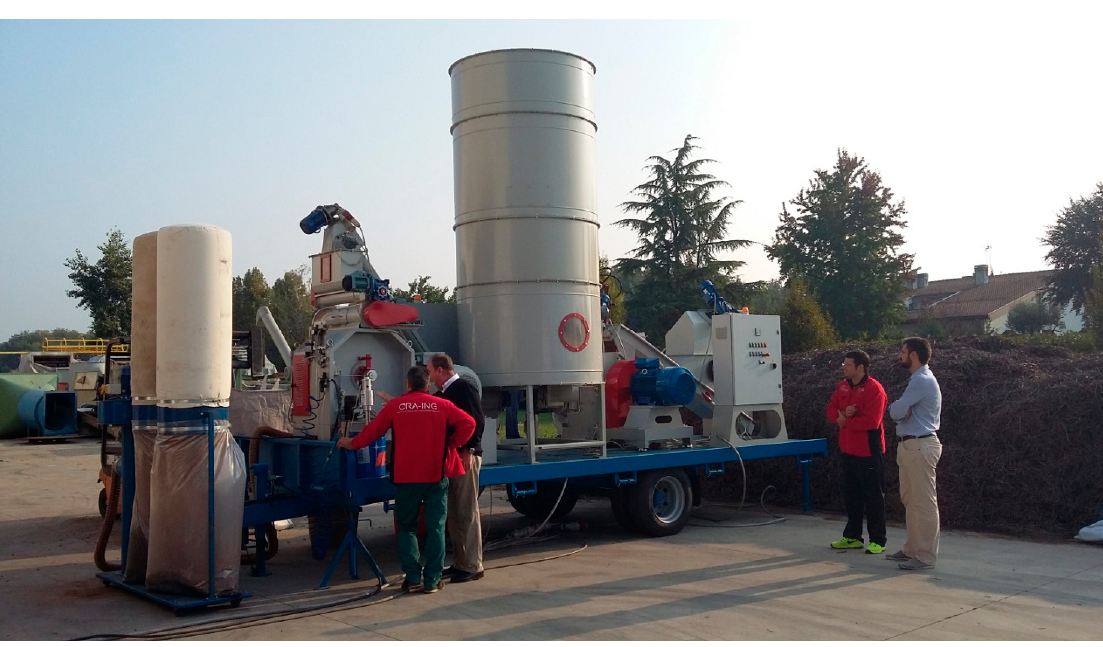
Figure 2. Mobile pelleting plant developed by Costruzioni Nazzareno.